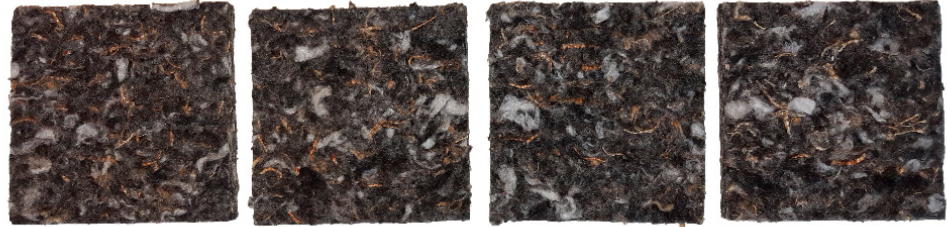
6 of 15 Figure 3. Scheme of device for measuring of sound absorption coefficient. 2.2. Thermophysical Properties Thermophysical properties were measured on samples with dimensions 100 mm × 100 mm and thickness of 13 mm (Figure 4). From total number of 42 samples, 21 pairs were formed for determination of thermophysical properties. Three pairs of samples were